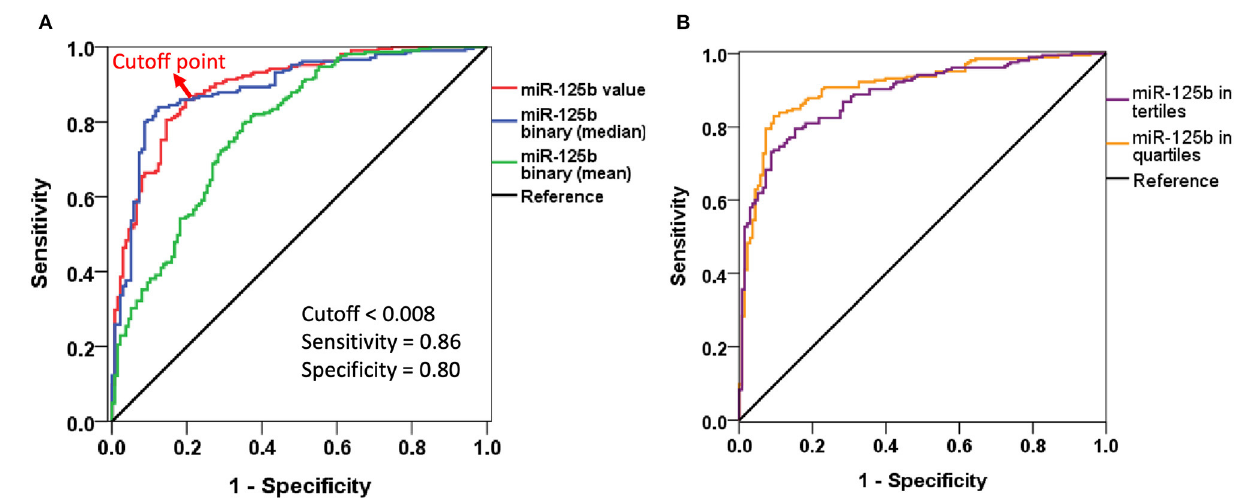
FIGURE 1 | Receiver-operating characteristics curves of different logistic regression models incorporating miR-125b levels. (A) Including miR-125b value or in binary division. (B) Including miR-125b in tertiles or